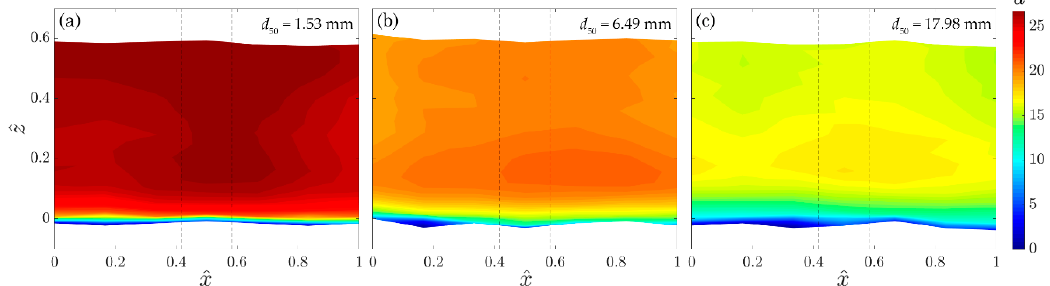
Figure 6. Contours of the dimensionless time-averaged streamwise velocities on the vertical central plane (from D to U) for ( a ) Run 1, ( b ) Run 2, and ( c ) Run 3. The black broken lines indicate the cylinder location.